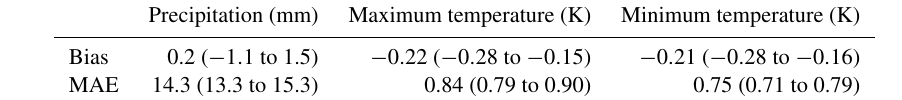
Table 5. Calibration sample evaluation statistics for TIER using the default parameters with 90% confidence intervals in parentheses.